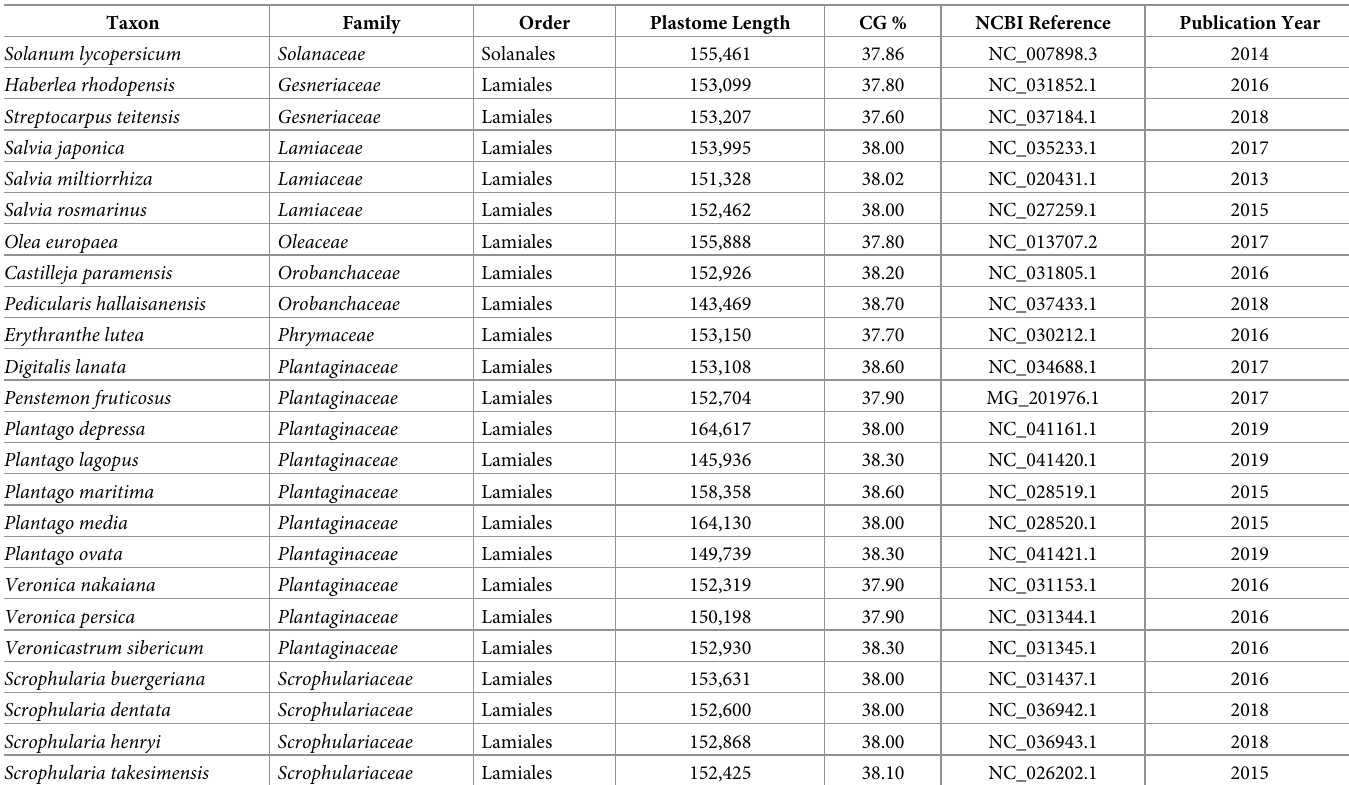
Table 1. Lamiales order and outgroup taxa included in our phylogenetic